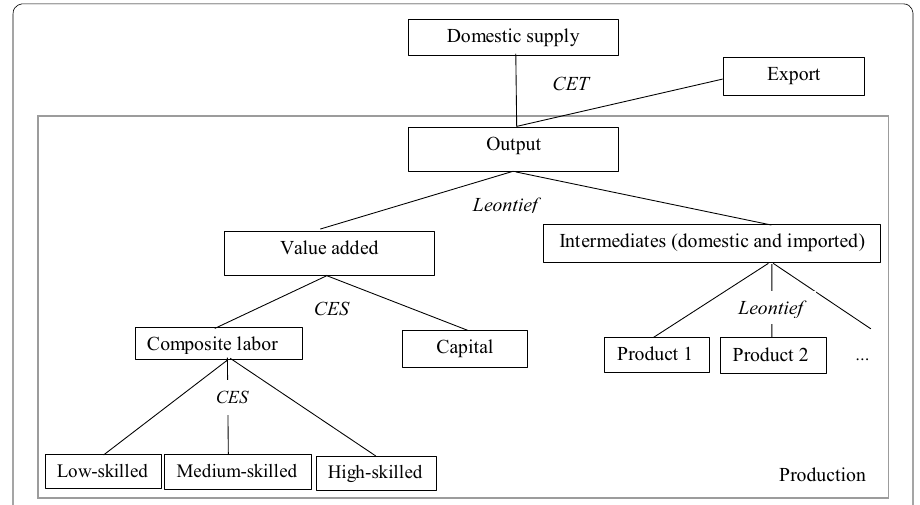
Fig. 2 Nested structure of production framework. Source : Adopted from PEP 1.1